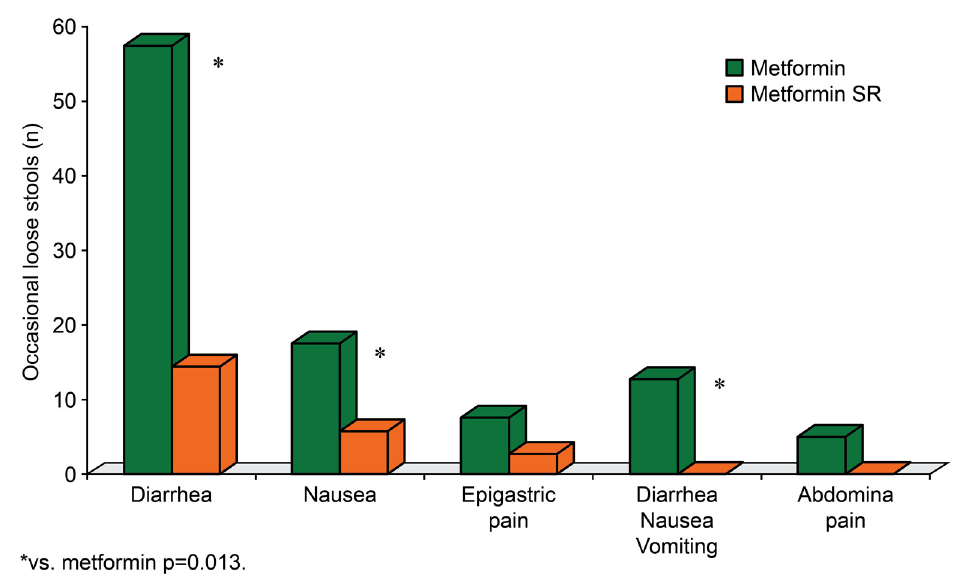
Figure 1. Gastrointestinal disturbance with metformin SR vs. metformin (immediate release); SR: Sustained release. Adapted from Levy et al., 2010 [21].